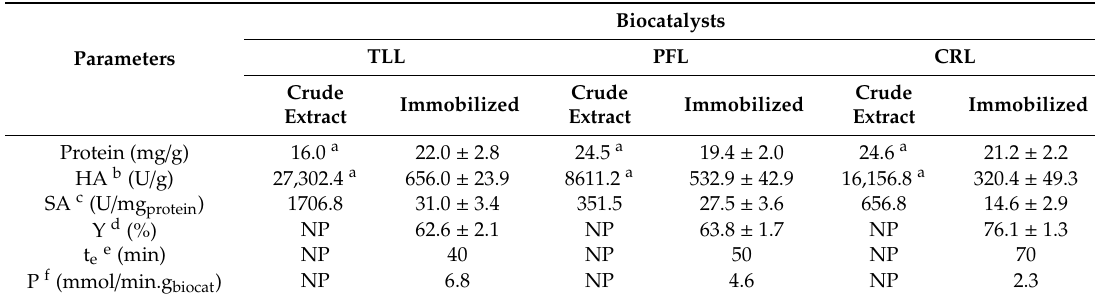
Table 1. Characterization of the heterogeneous biocatalysts prepared in this study and their performance in ester